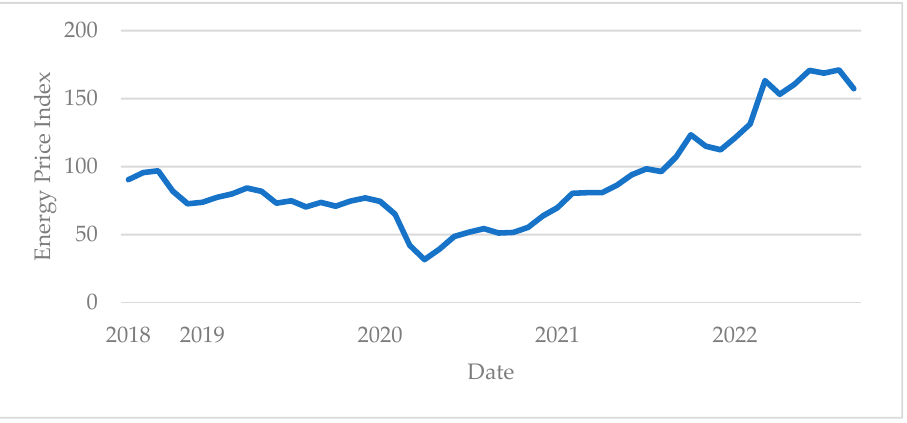
Figure 2. Energy Price Index. Source: https://ycharts.com/indicators/energy_index_world_bank (accessed on 23 October 2022).